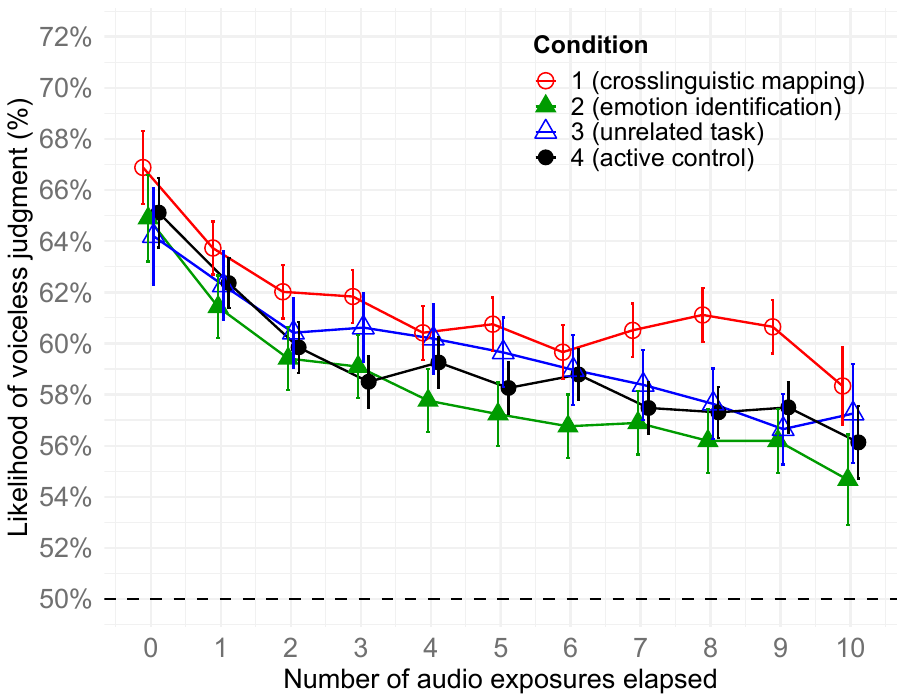
Figure 9. Likelihood of voiceless identification (averaged over bilabials and velars), by number of audio (FL or non-linguistic) exposures and task condition. Points represent the group mean at the given number of exposures in the given task condition. Error bars indicate standard error. The dashed line represents the chance value for the binary judgment.